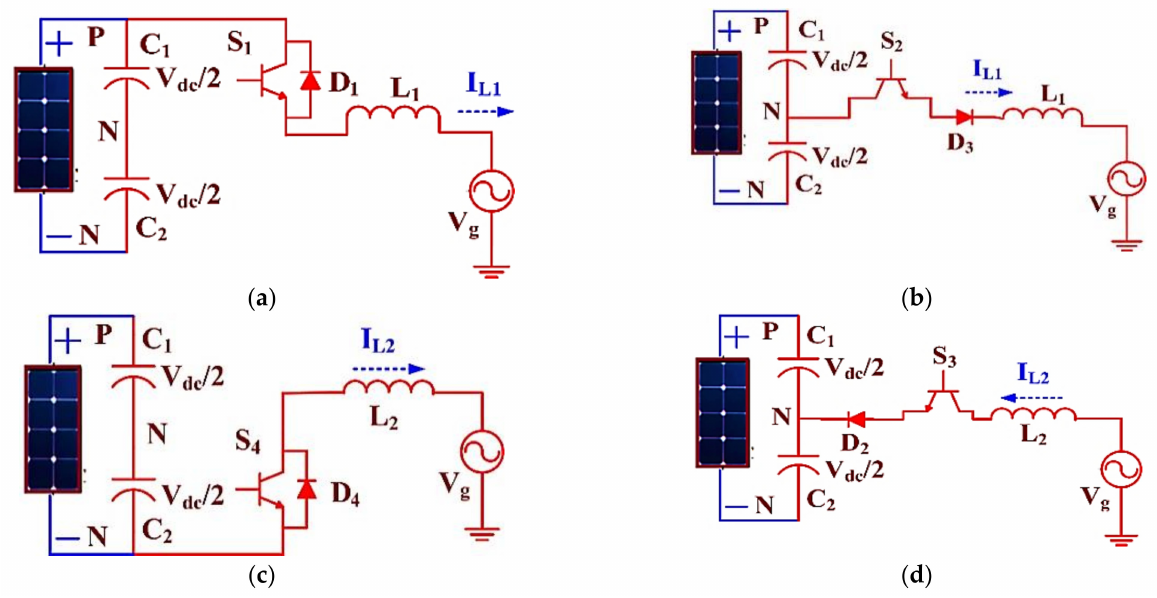
Figure 2. Mode of operation of transformer-less TNP-MLI: ( a ). Mode 1, ( b ). Mode 2, ( c ). Mode 3, ( d ). Mode